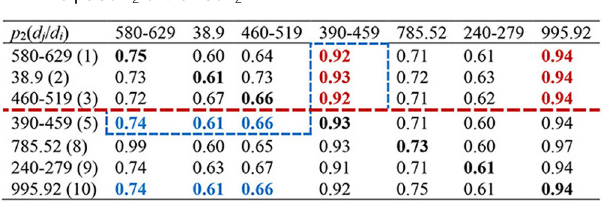
TABLE 3 | CCoM 2 of the LCoP 2 .